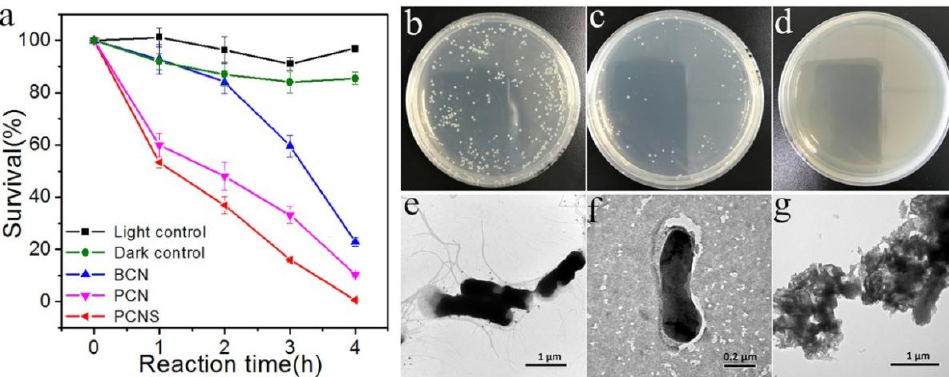
Figure 20. ( a ) Visible − light − driven photocatalytic disinfection performance against E. coli over BCN (bulk g − C 3 N 4 ), PCN (porous g − C 3 N 4 ) and PCNS (porous g − C 3 N 4 nanosheets). Images of E. coli on solid culture medium before ( b ) and after (( c ) 2 h; ( d ) 4 h) light irradiation on PCNS. TEM images of E. coli cells ( e ) before irradiation and ( f , g ) after disinfection for 4 h on PCNS. Used with permission from [197]. Copyright 2017 American Chemical Society.